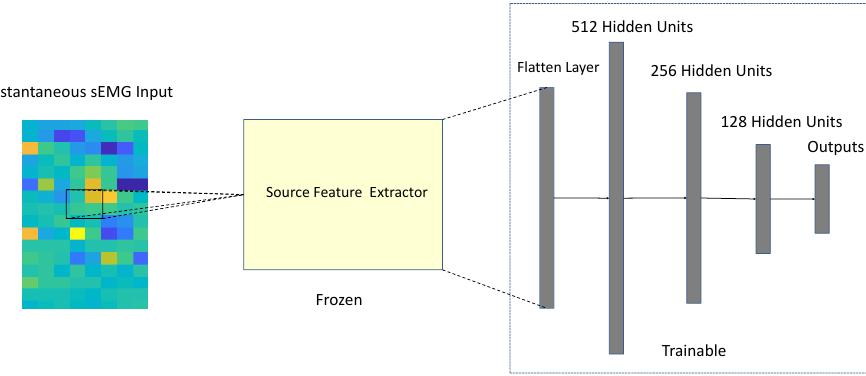
Figure 4. The architecture of the target network with the transfer learning (TL)